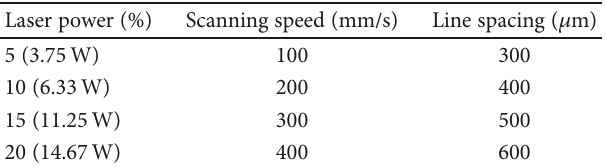
Table 1: The range of setting sued for laser engineering structures onto the PET surface. Every combination was tested, resulting in 64 total sample